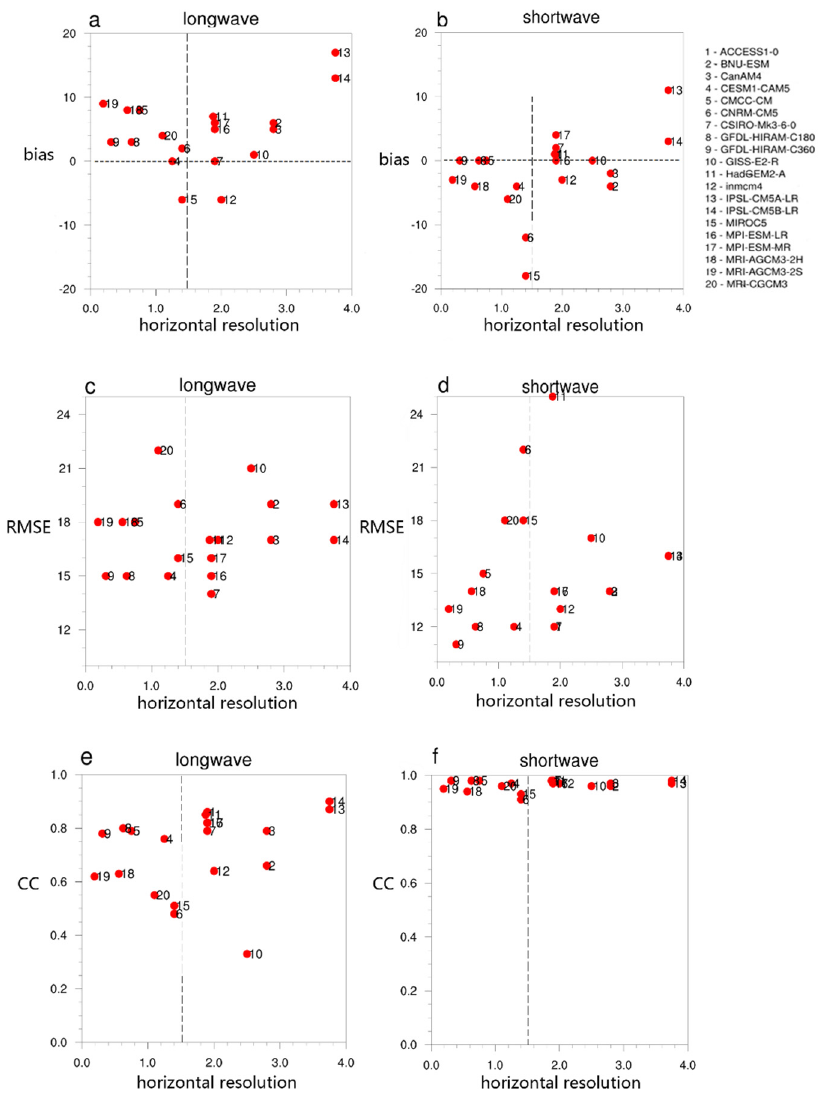
Figure 12. (top) Distribution of horizontal resolution (in ◦ ) and bias (W m − 2 ) from 20 models over 30 ◦ S to 30 ◦ N from 1979 to 2000 for ( a ) longwave Q LW and ( b ) shortwave Q SW. The middle ( c , d ) and bottom ( e , f ) panels are for RMSE (W m − 2 ) and CC, respectively.